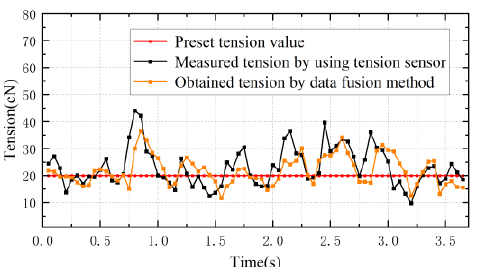
Figure 19. Tension control experiment using data fusion method.